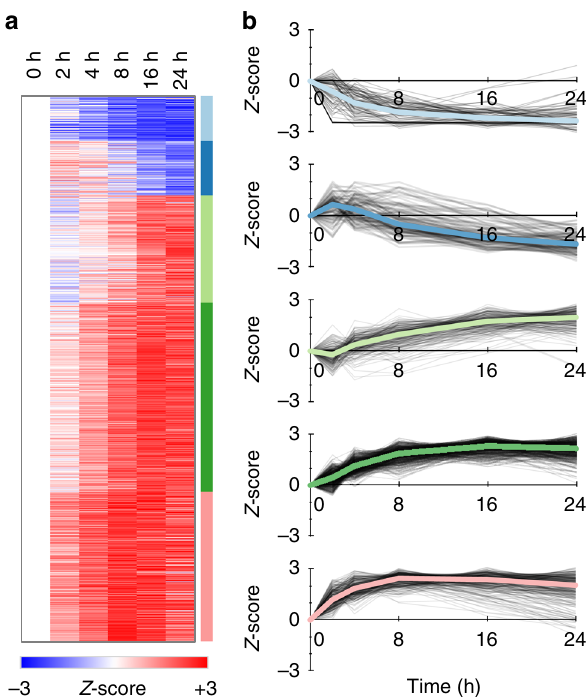
Fig. 6 Protein quanti fi cation changes following serum starvation. a Heatmap of 1097 proteins found to be quantitatively changing at a q -value < 0.01 in HeLa. Colors are Z -score normalized and indicate the number of standard deviations away from the level at time 0. b Protein changes grouped into fi ve K-means clusters (see Supplementary Figure 13 for more details) showing separation between fast responding proteins (light blue, dark green, and pink) and delayed responses (dark blue, light